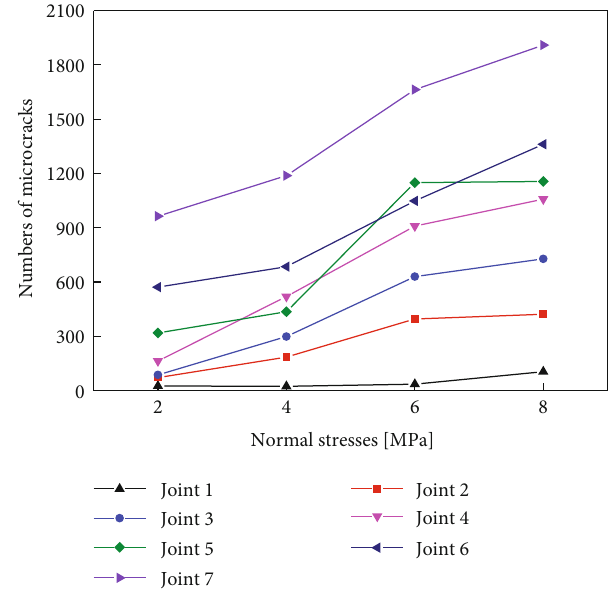
Figure 12: The in fl uence of normal stress of joint samples on number of